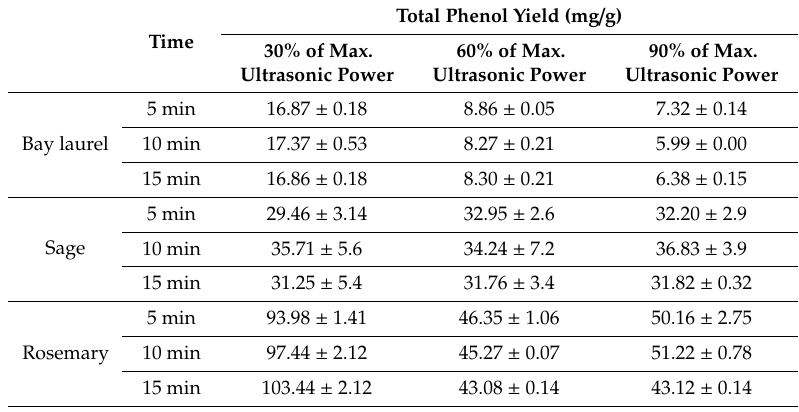
Table 1. Optimization of ultrasound extraction parameters based on the total phenol